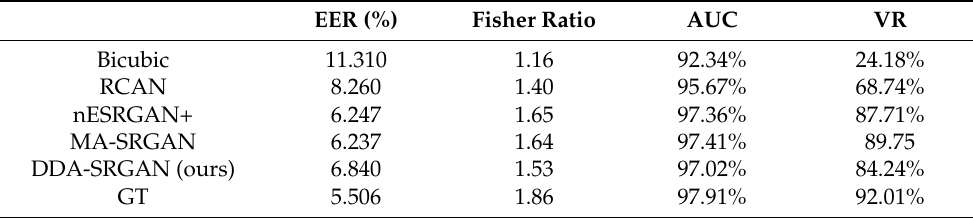
Figure 15. Detailed comparison of ROC curves for each SR model on the CelebA dataset. In the detailed comparison, we can find that the bicubic SR images downgrade the recognition accuracy to roughly 68% when FAR = 5%, and the various SR methods mitigate this gap. Among them, the proposed method achieves an acceptable performance without prior knowledge of ROI. Table 5. Comparison of the proposed method with different SR models for face recognition.